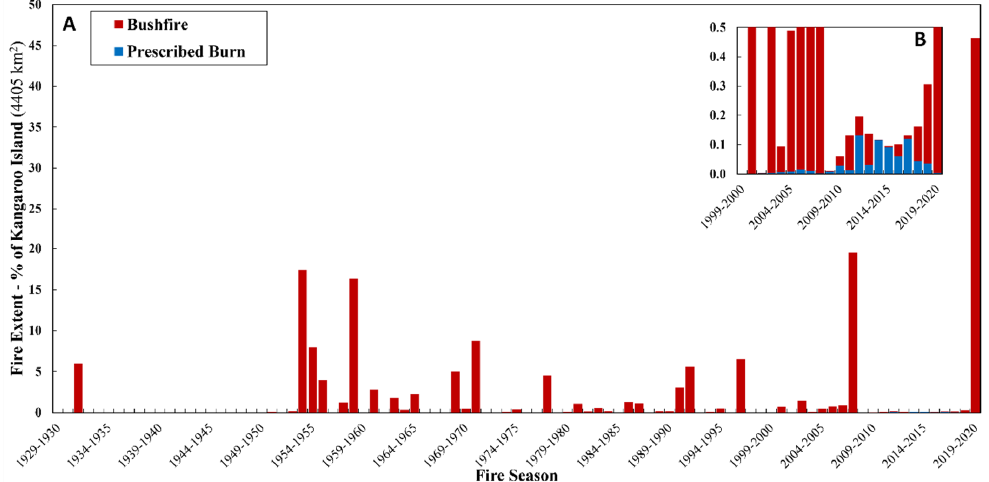
Figure 6. Percent of Kangaroo Island burned in each fire season from 1929–30 to 2019–20 ( A ), based on the size of fire history polygons [45] to be consistent across the entire record. Polygons from 1950 and onwards were used in the creation of fire history variables (BLX, SLB). Prescribed burns are planned fires on government land and are minor compared to bushfires. Inset graph ( B ) with all recorded burns since 2000 shows that prescribed burns never burned more than 0.2% of Kangaroo Island in a single season.